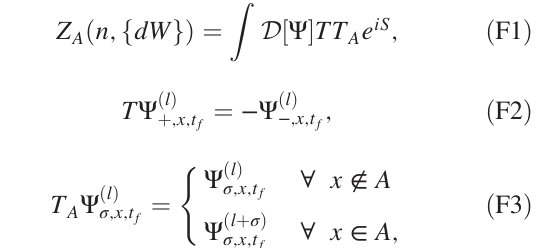
ffiffiffiffiffiffiffiffiffiffiffiffi